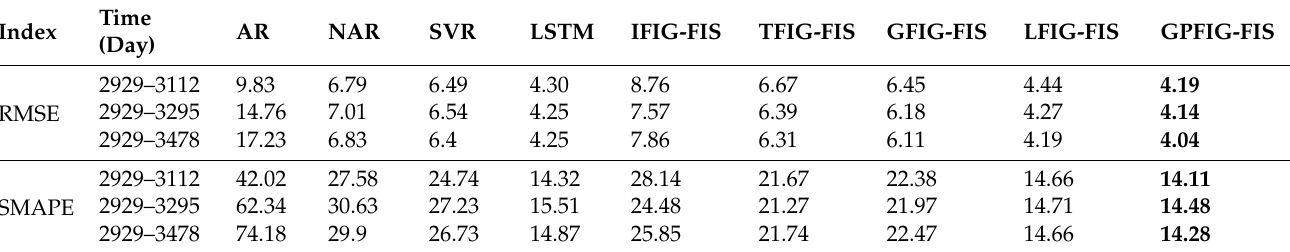
Table 1. Comparison of the prediction indexes of daily minimum temperature.